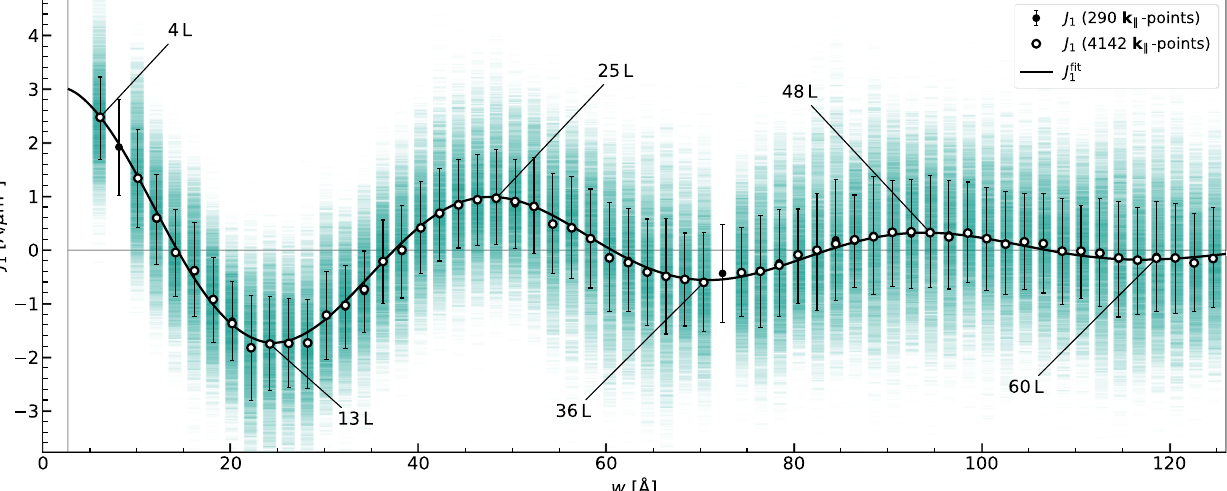
ð w Þ [ J fi t 1 1 “ errorbars ” ∥ -points. The vertical